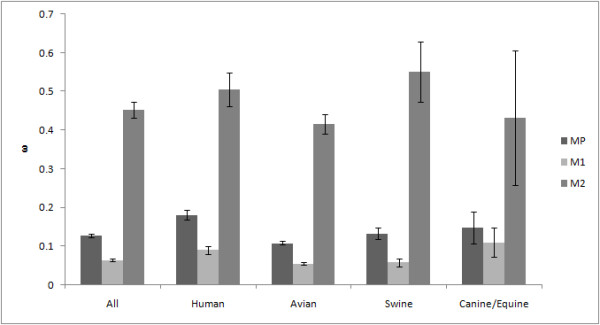
Selective pressure among hosts. Selective pressures for the entire sequence (ω) are calculated for the entire coding region of the M gene, and separately for M1 and M2. Error bar shows 95% confidence interval.